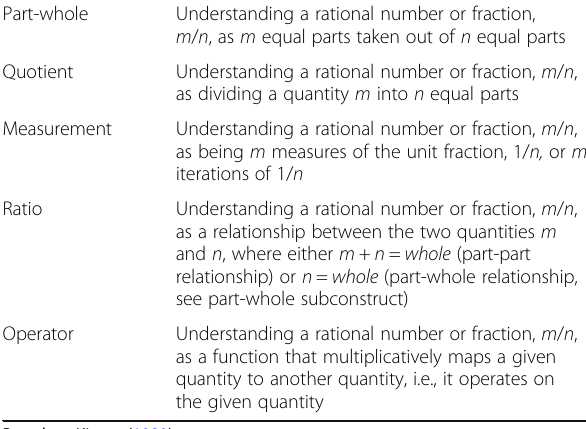
Table 2 Five subconstructs of rational number